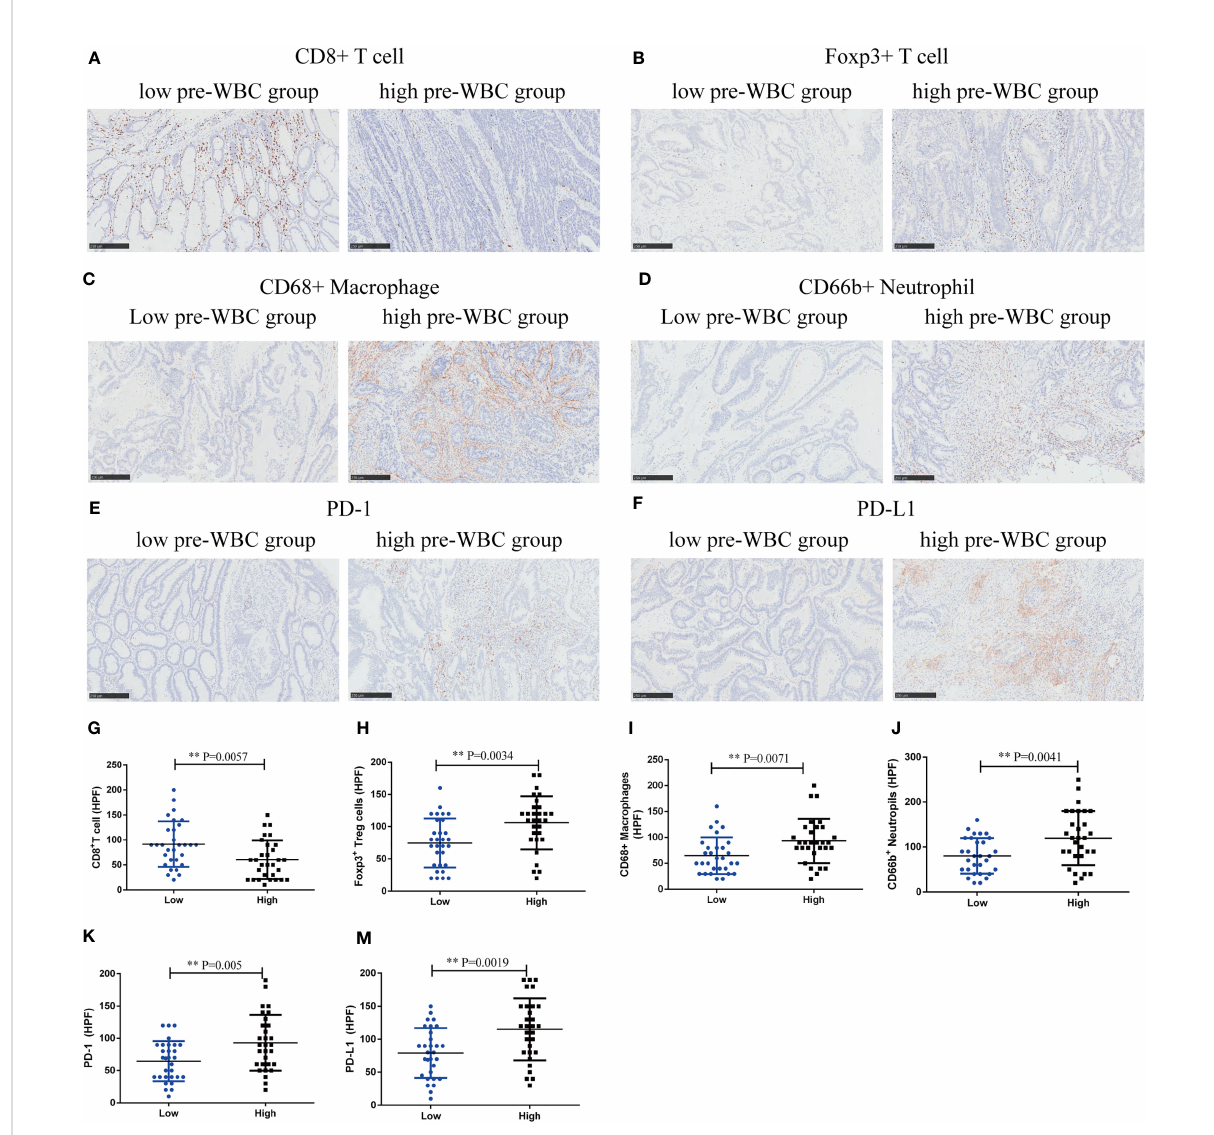
FIGURE 4 High preoperative WBC group was associated with immunosuppressive contexture in CRC. (A – F) . Representative immunohistochemical (IHC) staining of CD8 + T cells, Foxp3 + Tregs, CD68 + Macrophages, CD66b + Neutrophils, and immunosuppressive checkpoints (PD-1, PD-L1) between high and low preoperative WBC groups. (G – M) Comparison of CD8 + T cells, Foxp3 + Tregs, CD68 + Macrophages, CD66b + neutrophils and immunosuppressive checkpoints (PD-1, PD-L1) between two groups. n=30 in each group. Differences were considered signi fi cant at ** P < 0.01, compared to the low preoperative WBC